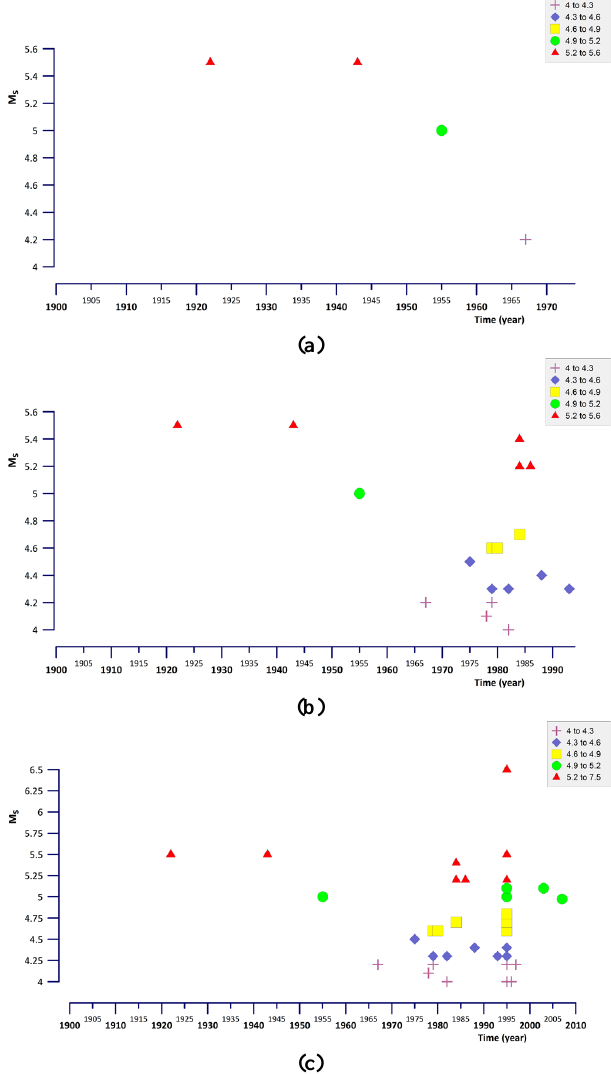
Fig. 6. (a) Temporal distribution by magnitude for the period: 1900– 1973. (b) Temporal distribution by magnitude for the period: 1900– 1994. (c) Temporal distribution by magnitude for the period: 1900–